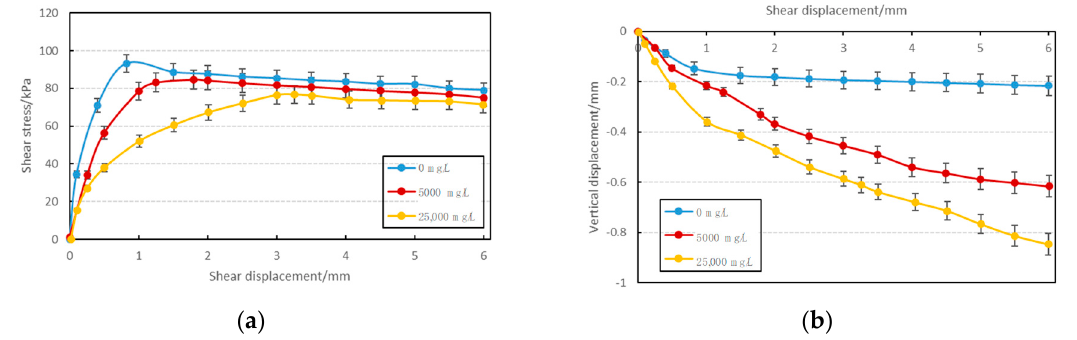
Figure 9. Shear properties of the specimens with various initial sulfate concentrations under a normal stress of 150 kPa (treated for 1 day; CPB made with 0.3% fibers). ( a ) shear stress vs. shear displacement. ( b ) vertical displacement vs. shear displacement.